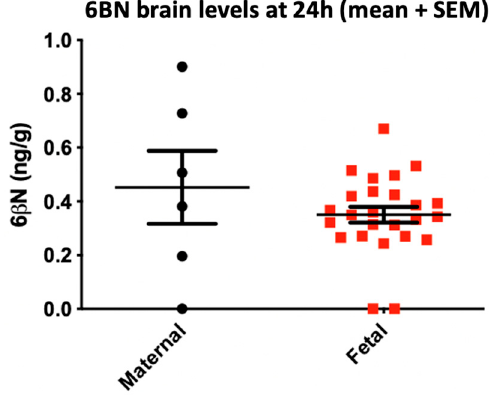
Figure 3. Maternal and fetal brain 6BN levels 24 h after s.c. doses of 1.0 mg/k to pregnant guinea pigs (gestational day 48–51). 6BN brain levels measured with a mass spectrometry assay (described in [61]) remain detectable (~0.5 ng/g, or ~1.5 nM, mean) 24 h after dosing in both dam and fetus. Maternal blood levels decline with a t1/2 of ~3o min in the first 6 h after administration and then become undetectable (~0.1 ng/mL) (performed under an NCATS-Aether CRADA agreement 14112019BC, by Lovelace Biomedical).